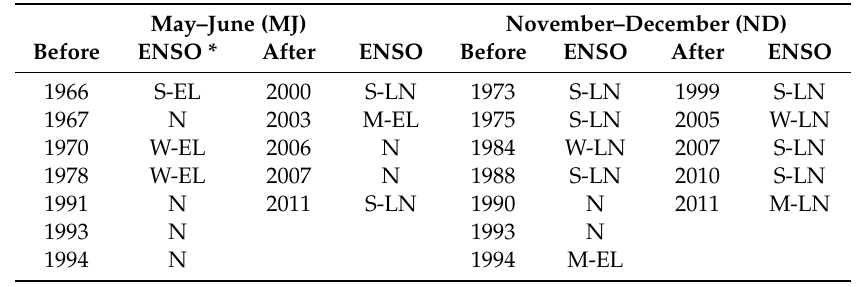
Table 2. Years with extreme flow events at Bellavista in May–June (MJ) and November–December (ND) before and after